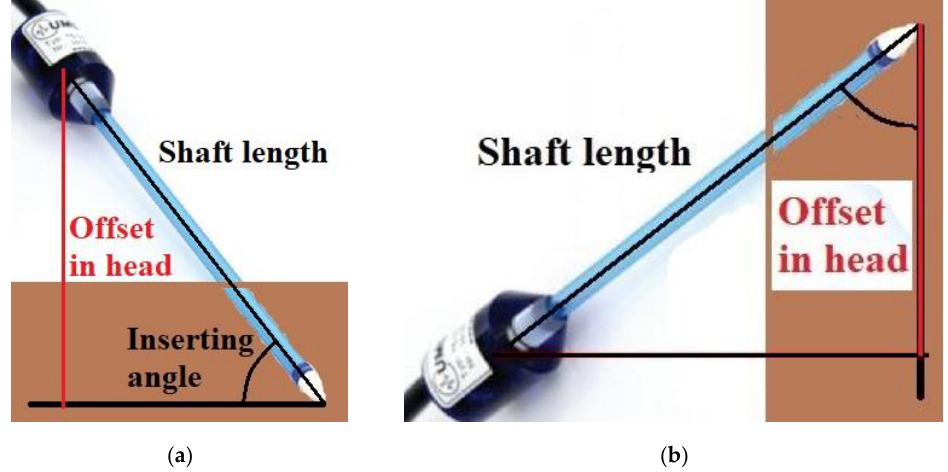
Figure 6. An illustration of the offset caused by inclined insertion: ( a ) the actual pressure head = the reading pressure head + the shaft length × the sine of the inserting angle; ( b ) the actual pressure head = the reading pressure head – the shaft length × the cosine of the inserting angle [65].